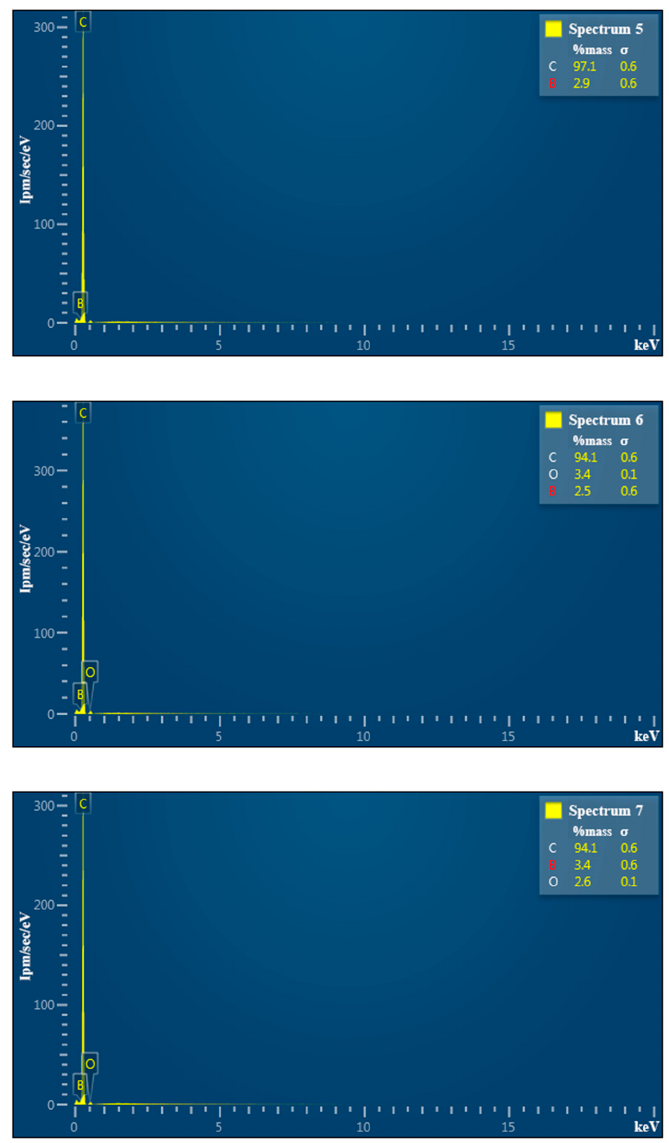
Figure 9. EDS analysis of Sample